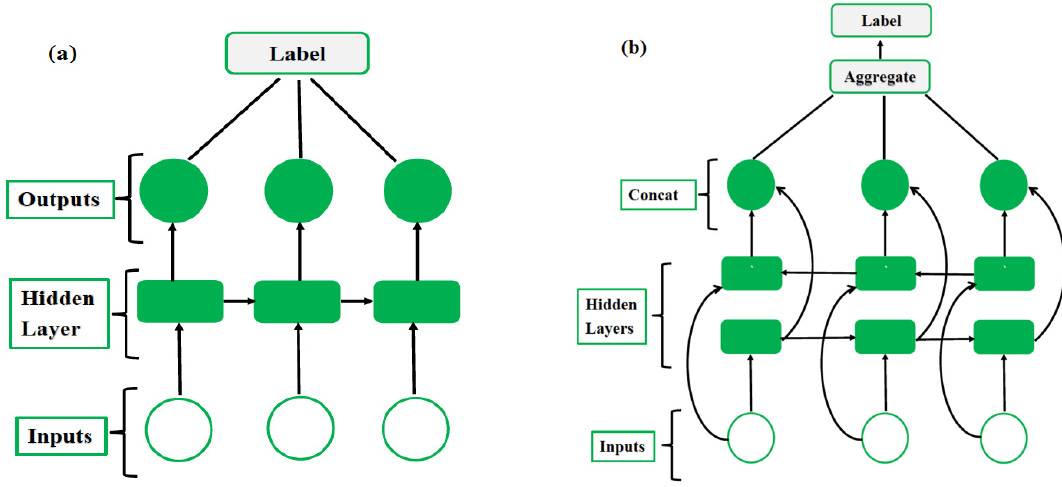
Figure 3. The basic structure of ( a ) long short-term memory neural networks (LSTM) and ( b ) bidirectional LSTM.